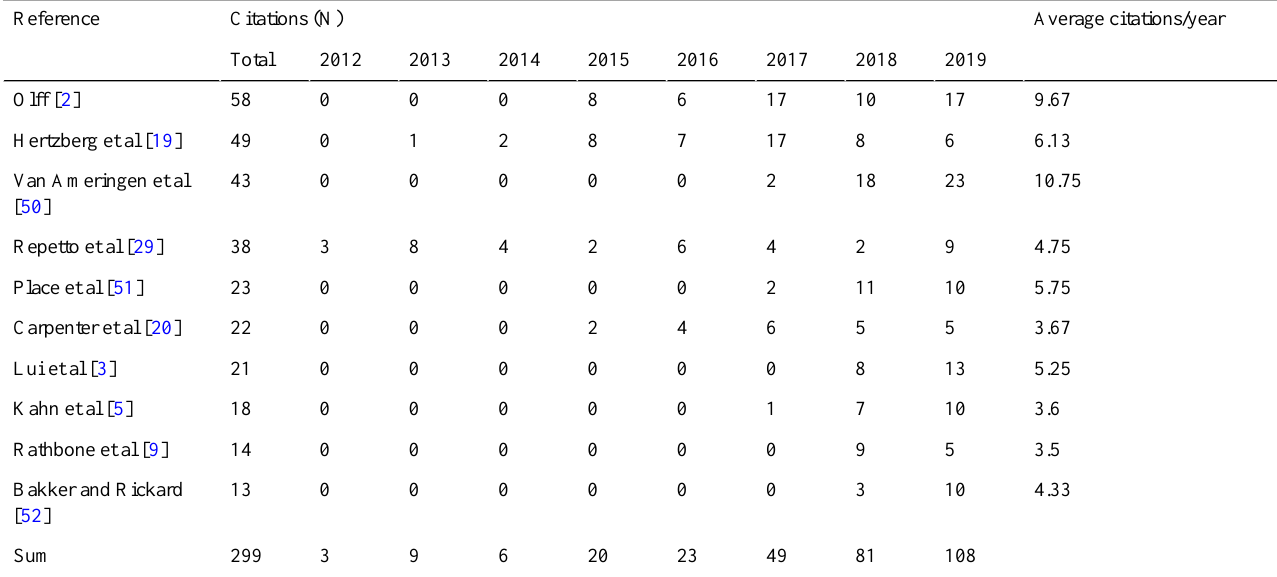
Table 5. Top 10 articles by citation results (2010-2019).